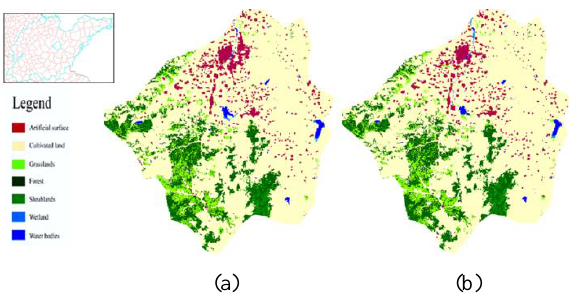
Figure 6. Land cover data for Shandong Linqu County,